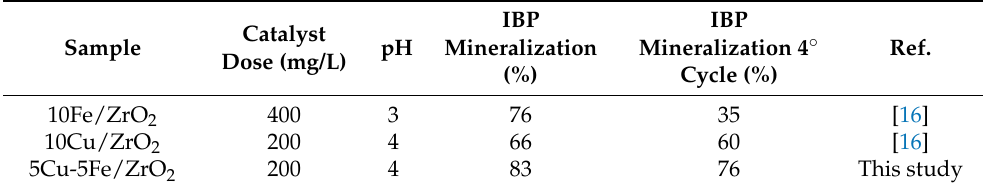
Table 3. Comparison between monometallic and bimetallic formulation with 10% loading of transi- tion